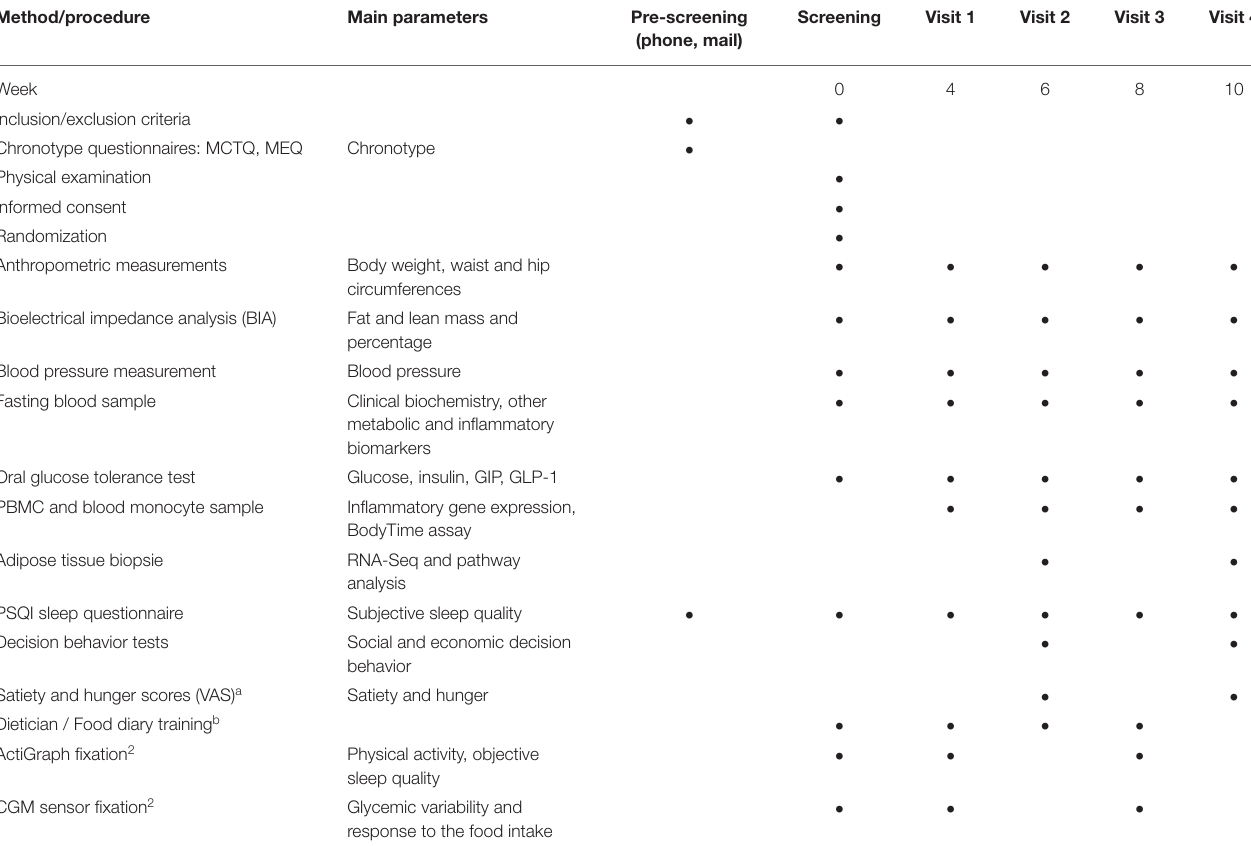
TABLE 1 | Overview of visits and